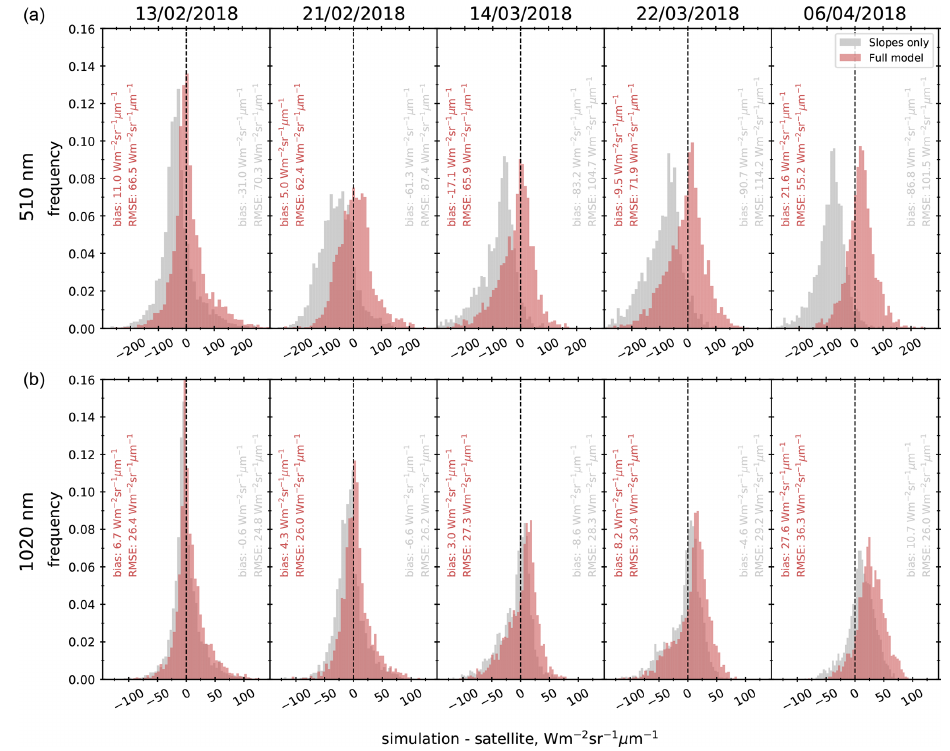
Figure 8. Distribution of the difference in TOA radiance between REDRESS simulations (red) and Sentinel-3 OLCI observations at band 05 (510nm, a ) and band 21 (1020nm, b ) for the five dates in 2018 over the study area. In grey is the same for simulations run considering slopes only. The bias and RMSE for REDRESS and REDRESS slope are indicated in each panel in red and grey,